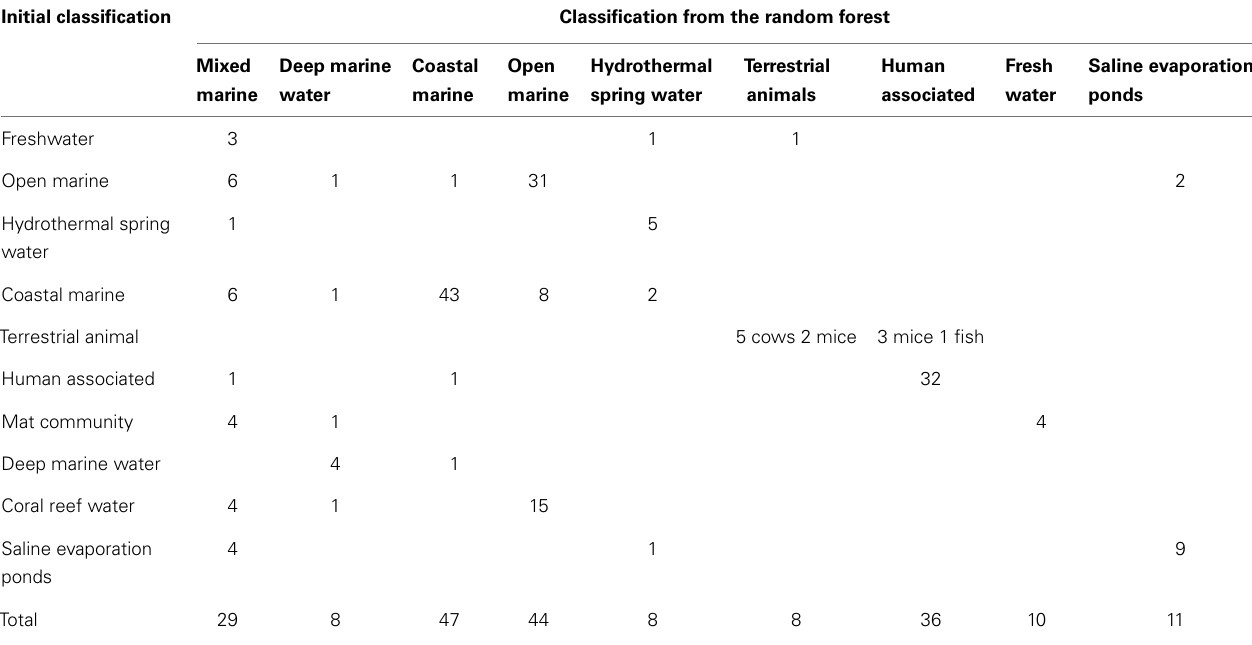
Table 3 |The group that each metagenome was assigned to by the random forest